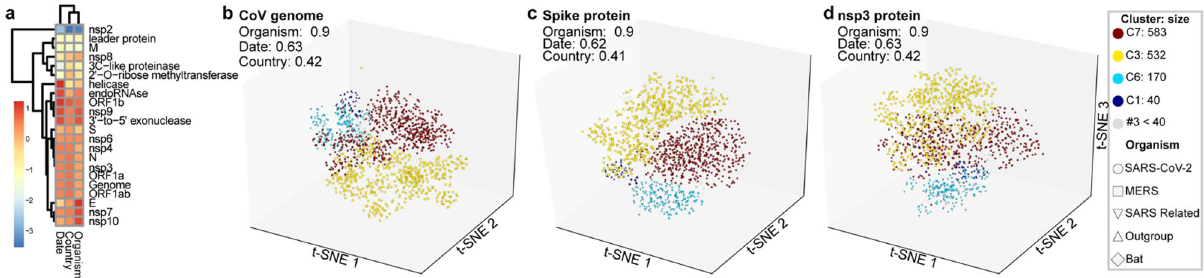
Figure 2. Subclade identification using CoV genome and gene variation in population of sample in our study. Subclade finding was performed using omeClust and enrichment score of metadata was measured based on the overlap of detected clades and metadata using normalized mutual information (NMI). ( a ) regions of CoV genome have been clustered using z-score of enrichment scores for three metadata variables available for all lineages. Regions such as S, nsp6, N, nsp3, ORF1a, ORF1ab are more similar to genomes using clusters of scaled enrichment scores. ( b ) omeClust identifies communities of CoV lineages that are mostly explained by organisms (NMI = 0.9). ( c ) Spike protein that facilitates binding and entering to host cells carries similar variation among organisms as the whole CoV genome. ( d ) nsp3 protein has a similar variation to S protein and can